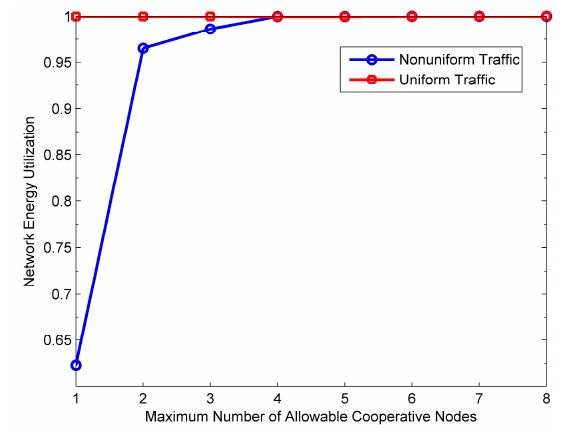
Figure 17. Network energy utilization vs. M .